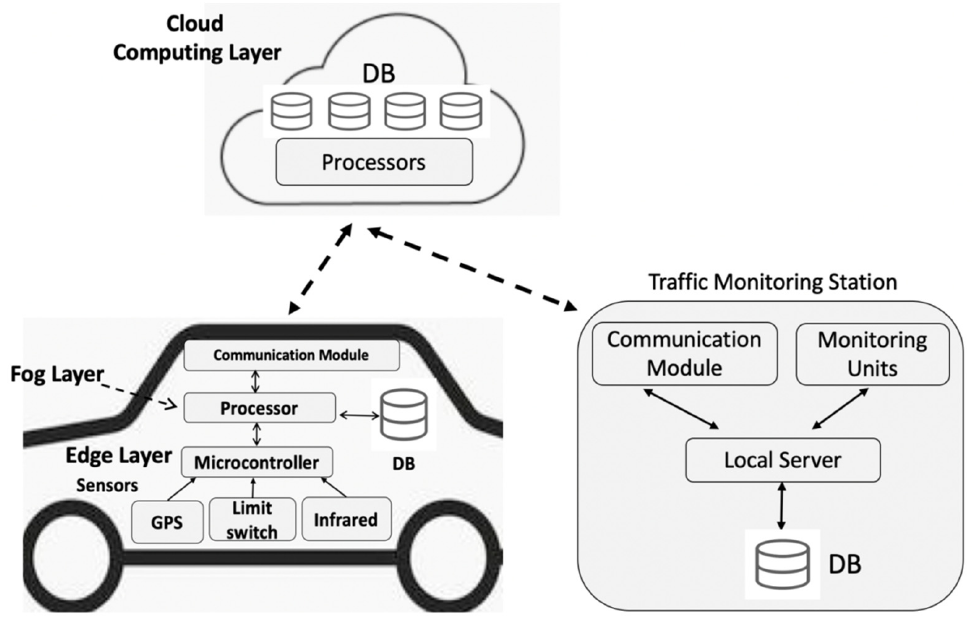
Figure 1. The proposed monitoring system architecture, which consists of a microcontroller con- nected to sensors as the edge layer, a processor as a fog layer, and a cloud layer connected to a traffic monitoring